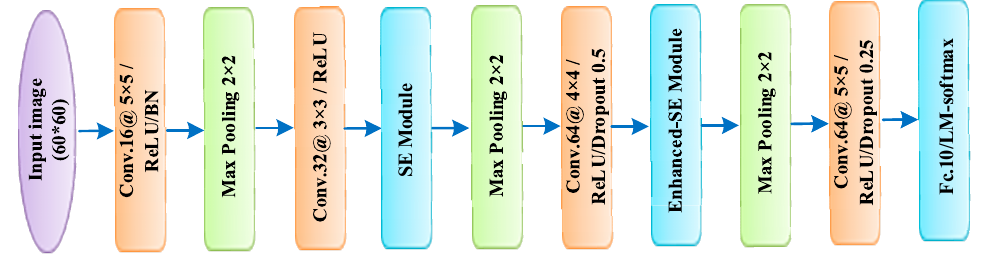
Figure 4. Structure of the Enhanced Squeeze and Excitation Net (ESENet).